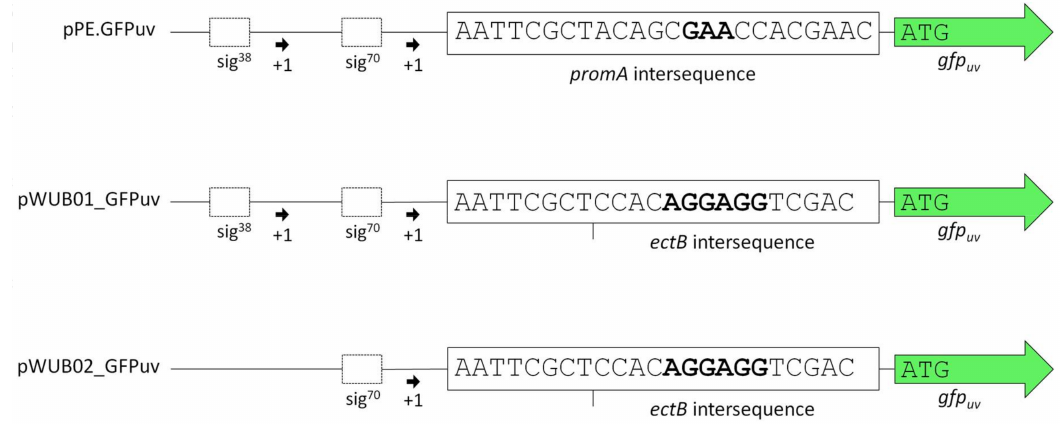
Figure 1. Schematic comparison of the promoter regions in plasmids pPE.GFPuv, pWUB01_GFPuv, and pWUB02_GFPuv. Sequences in bold represent the annotated RBS [4] in the promA intersequence of the wild-type and the Shine-Dalgarno consensus sequences upstream of the ectB